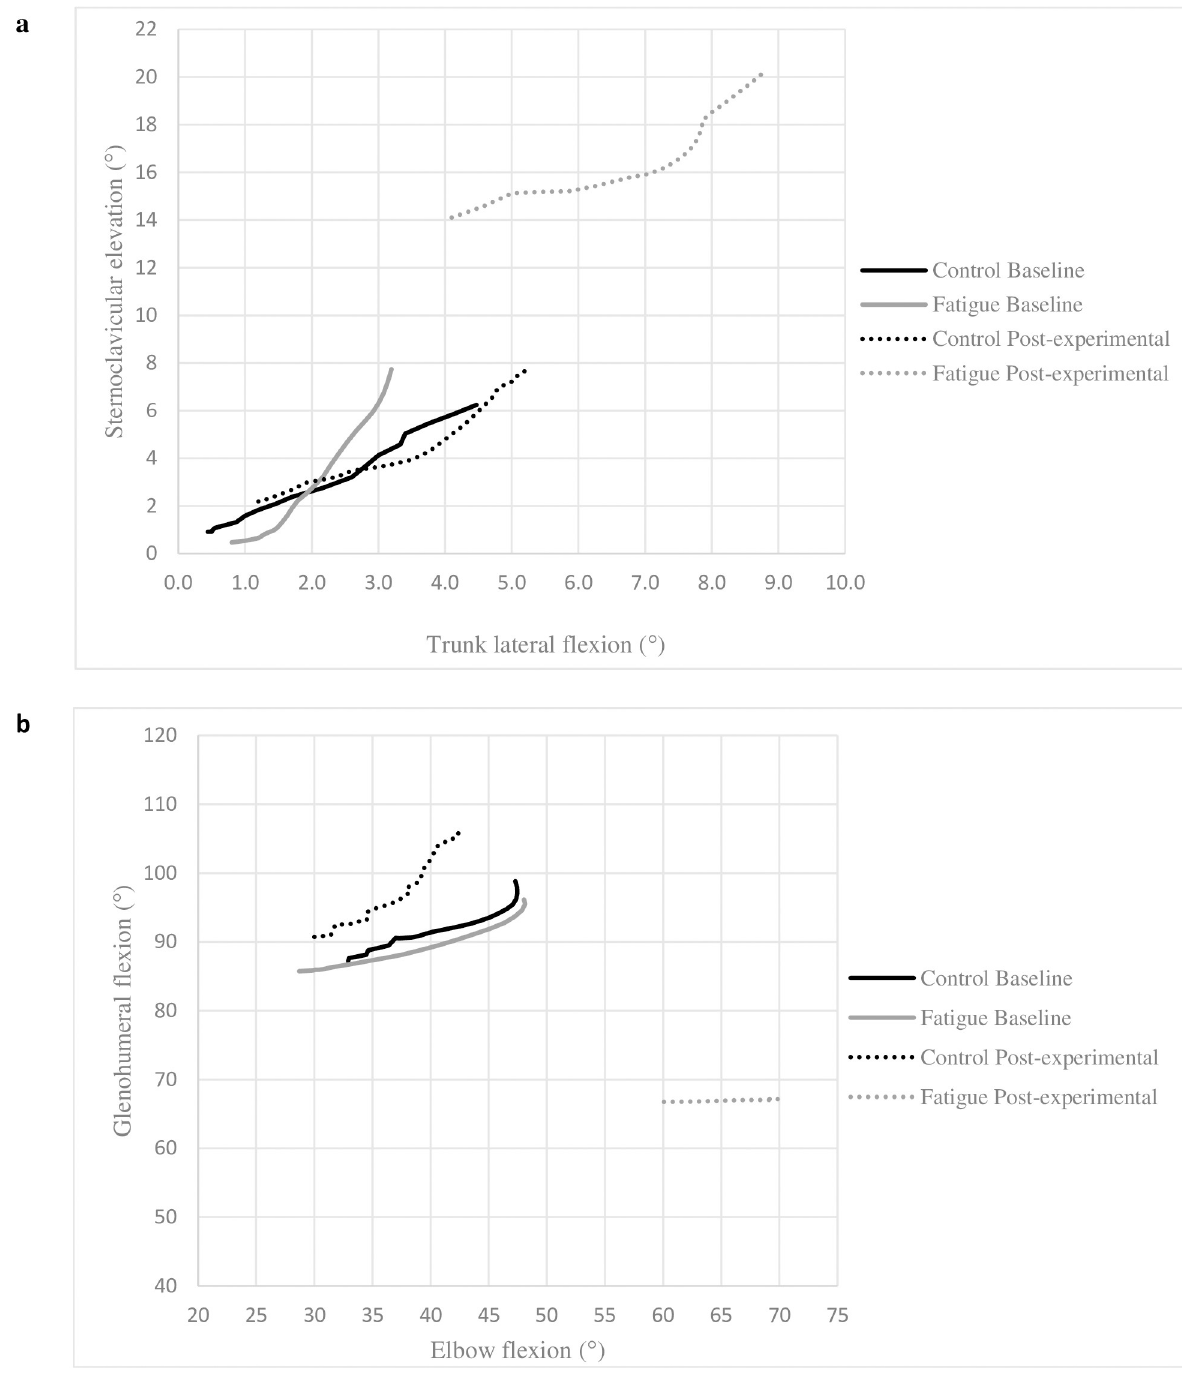
Fig 3. Inter-joint coordination at baseline and post-experimental phase. Inter-joint coordination while reaching target 2 (120˚ scaption). a. Trunk lateral flexion (LF) vs sternoclavicular (SC) elevation and b. Glenohumeral (GH) flexion vs elbow flexion. Trunk lateral flexion: positive value represents a LF ipsilateral to the reaching arm. Significant difference (Time x Group effect: p < 0.05) for SC elevation, trunk LF, GH flexion and elbow flexion between the phases. a. Fatigue group showed a significant increase of SC elevation and trunk LF initial and final positions and total excursion during post-experimental phase (p < 0.05). b. Fatigue group showed a significant decrease of GH flexion initial and final positions and an increase of elbow flexion initial and final positions; total joint excursion during post-experimental phase was decreased for both joints (p < 0.05).